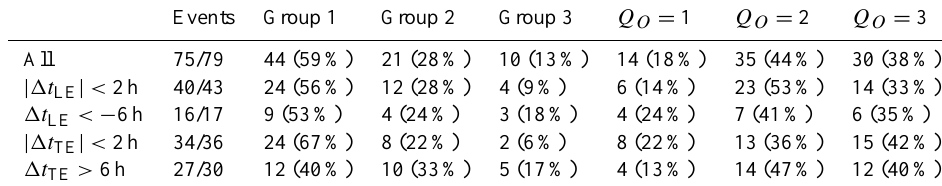
Table 1. The row “All” shows the distribution of all studied events to different P t groups and the flux rope fitting quality ( Q 0 ) categories (see Sect. 2 for definitions). Note that the P t group could be assigned only for 75 of events, while the quality category was available for all 79 events in our data set. The following rows show distributions separately for the events where the ICME and MC boundaries agreed ( | 1t LE | < 2h and | 1t TE | < 2h) and for the events where the boundaries differed significantly ( 1t LE < − 6h and 1t TE > 6h). The second column gives the total number of events in these categories (used to compute all percentages).